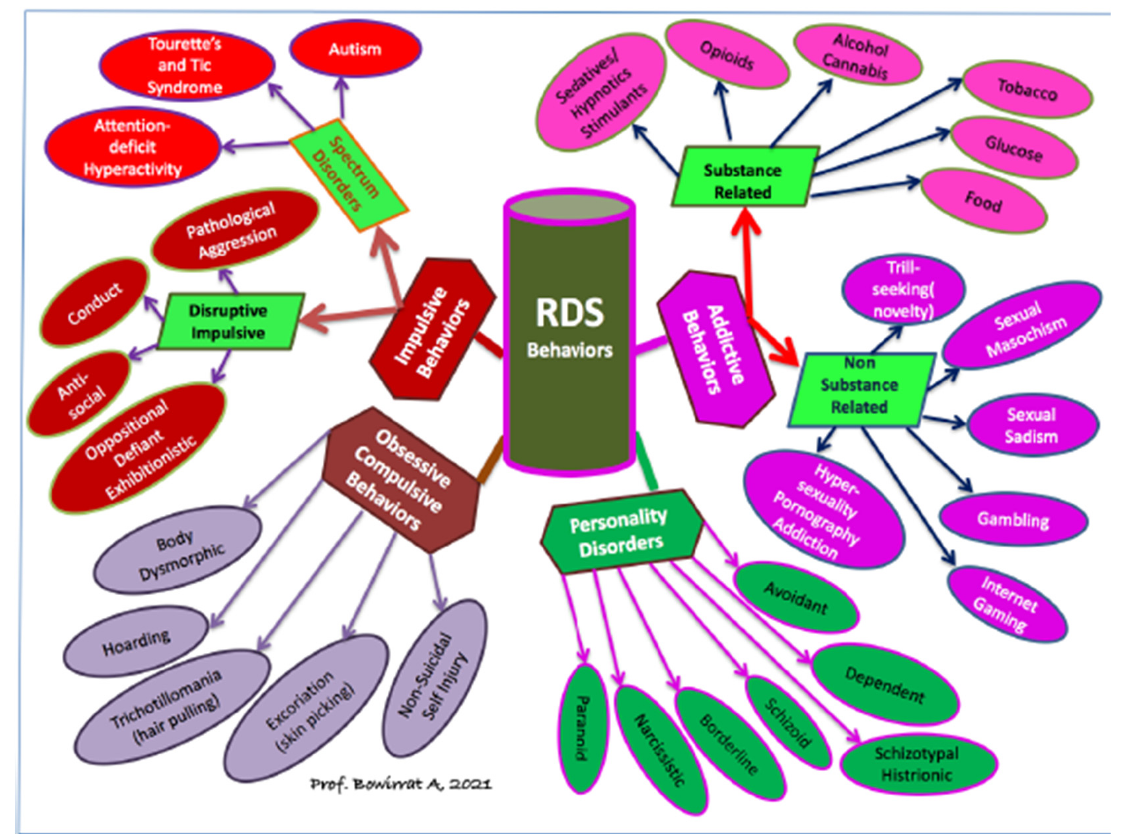
Figure 6. The Disease Model of Reward Deficiency Syndrome (RDS).